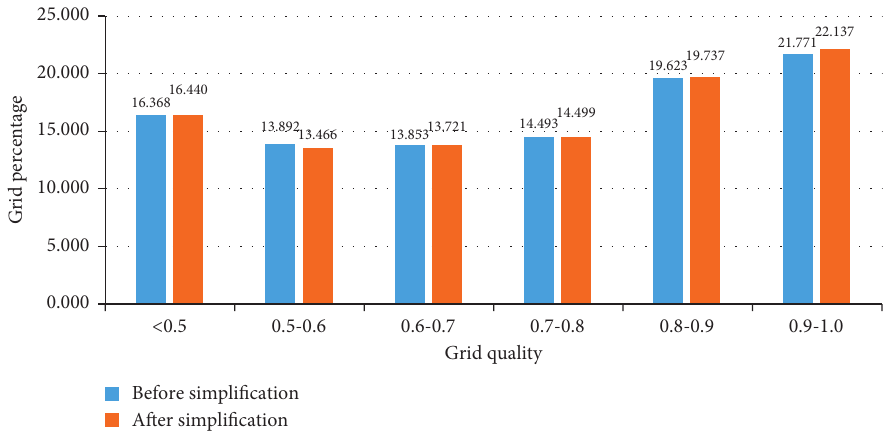
Figure 11: Comparison of grid quantity before and after